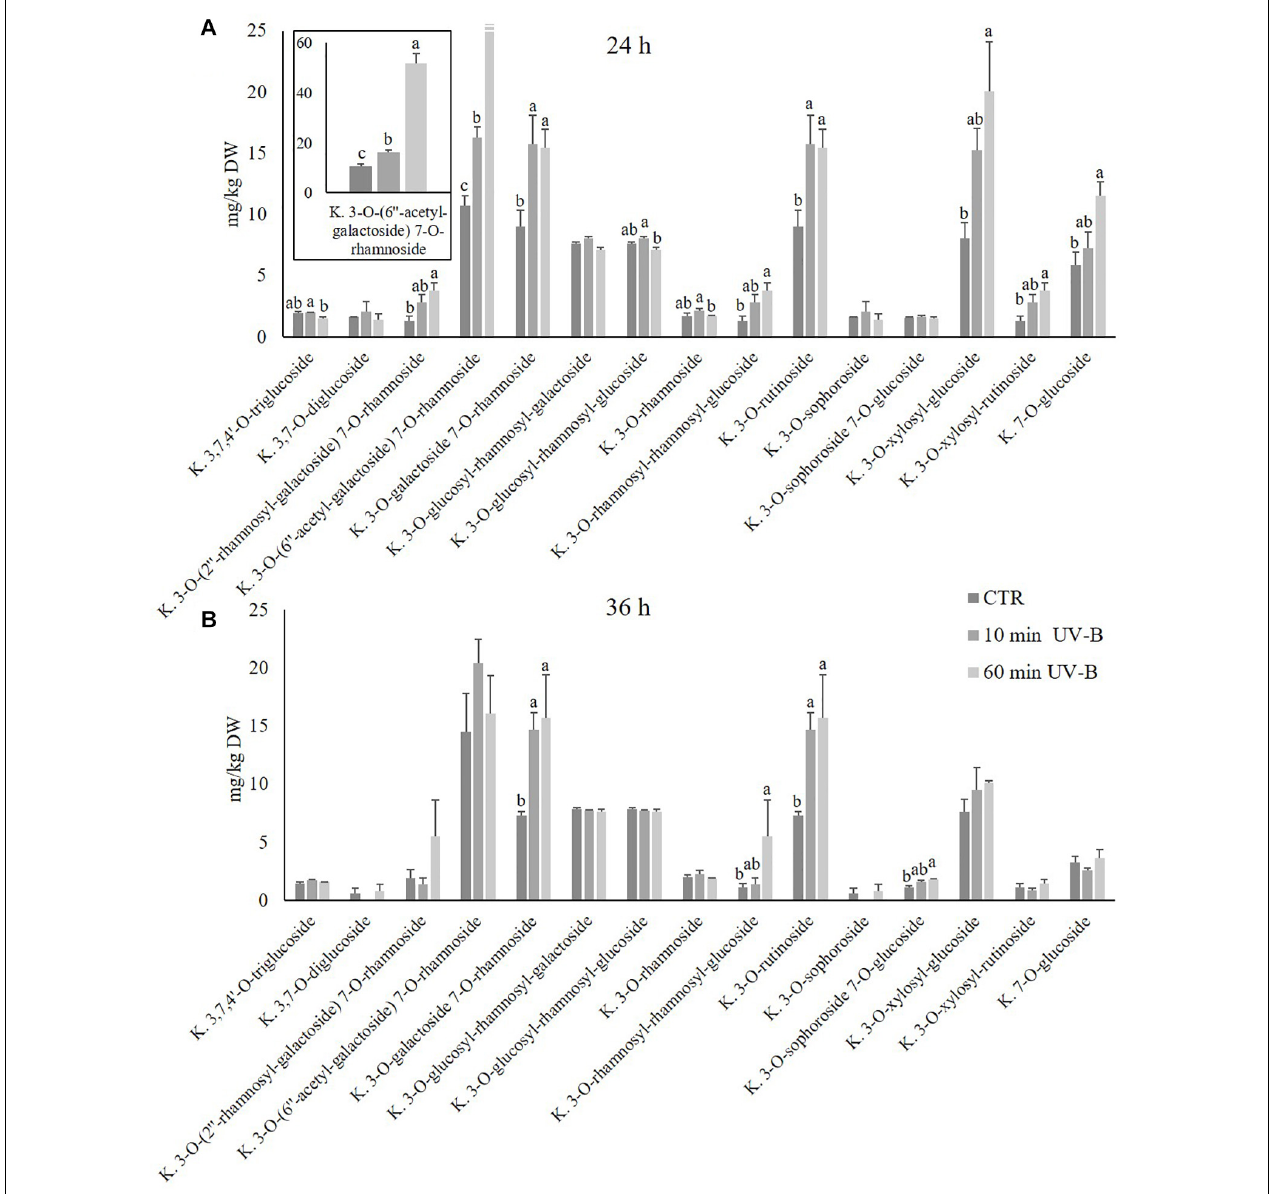
FIGURE 4 | Concentration (mg/kg DW) of different kaempferols in the pulp of peaches exposed to UV-B radiation for either 10 or 60 min and sampled after 24 h (A) and 36 h (B) from the exposure. (A) Kaempferol 3- O -(6 (cid:48)(cid:48) -acetyl-galactoside) 7- O -rhamnoside was reported also in a different, framed histogram with a higher y-axis scale (0–60 mg/kg DW) for a better visualization. Data are mean ± SE of five biological replicates. Different letters correspond to statistically significant differences according to one-way ANOVA followed by Tukey–Kramer post hoc test ( P ≤ 0.05).